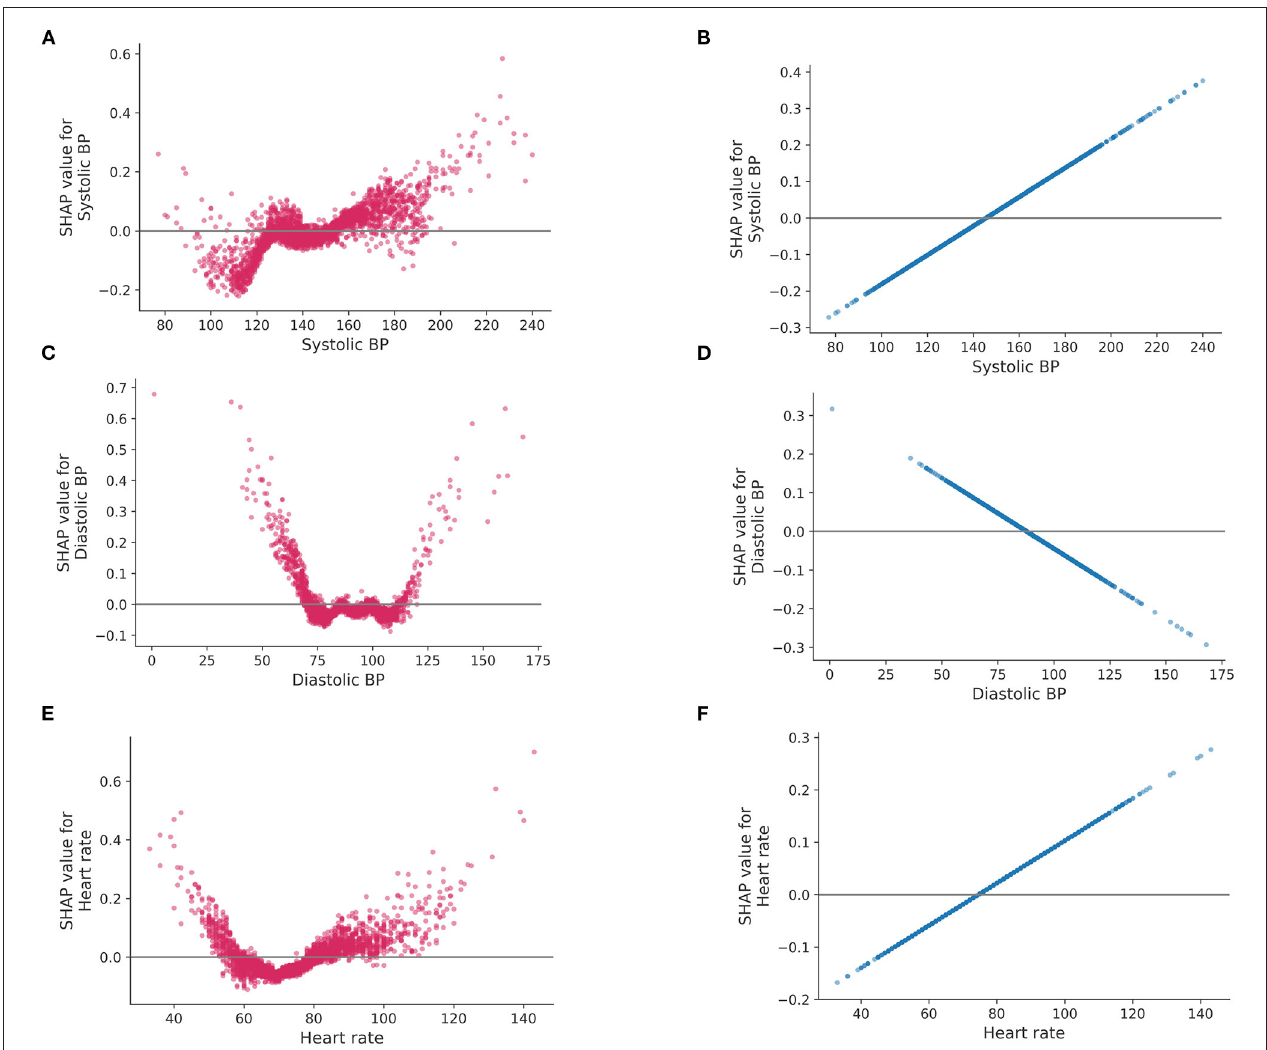
FIGURE 4 | SHAP values for a single feature. SHAP values (impact of each feature on the model) of logistic regression and Catboost are represented on the left and right side, respectively. Systolic blood pressure (A,B) , diastolic blood pressure (C,D) and heart rate (E,F) . BP, blood